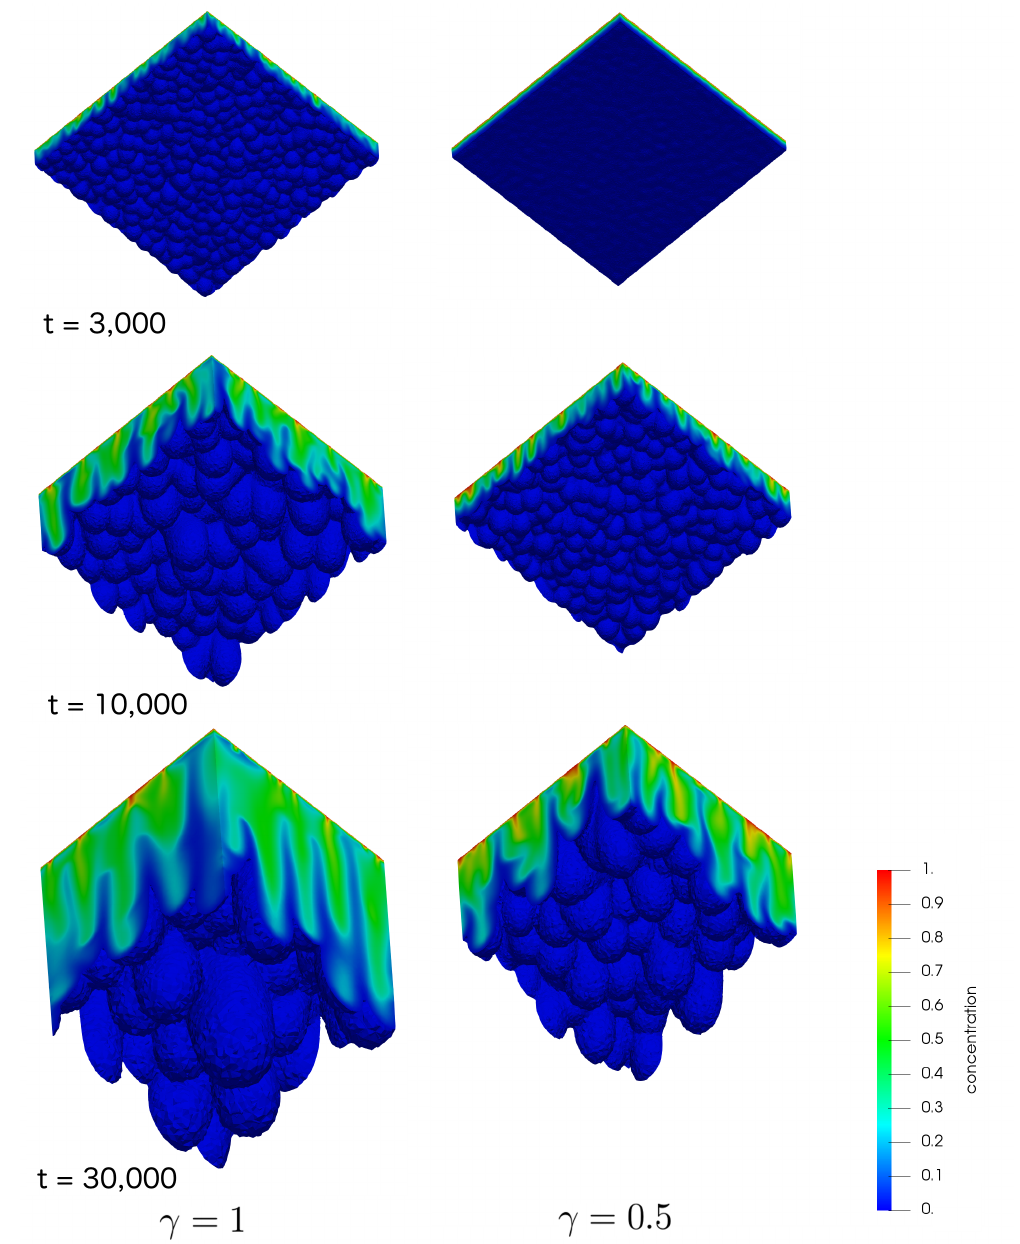
Figure 5. Comparison of the evolution of convective mixing in isotropic and anisotropic porous media. (i) γ = 1 ( left ); and (ii) γ = 0.5 ( right ). Only concentrations greater than 0.1 are shown. Time is